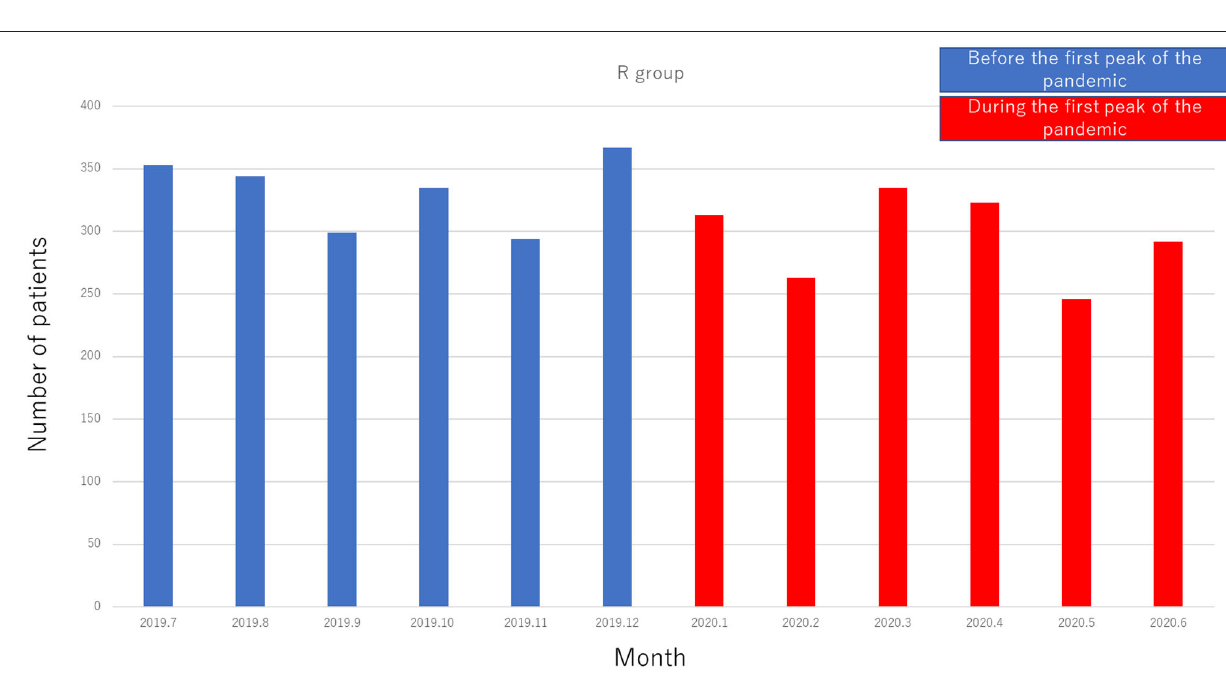
FIGURE 2 | Flow of patients who visit our hospital on a regular basis (R